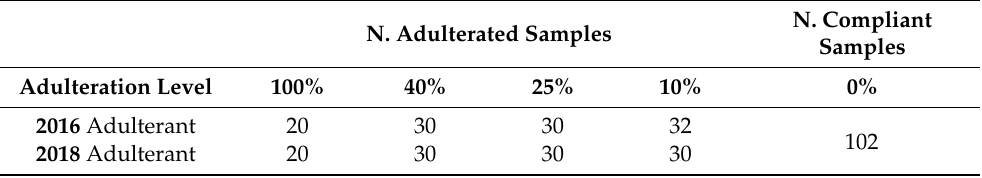
Table 3. The number of analyzed samples at the different adulteration levels and divided into Adulterated and Compliant saffron